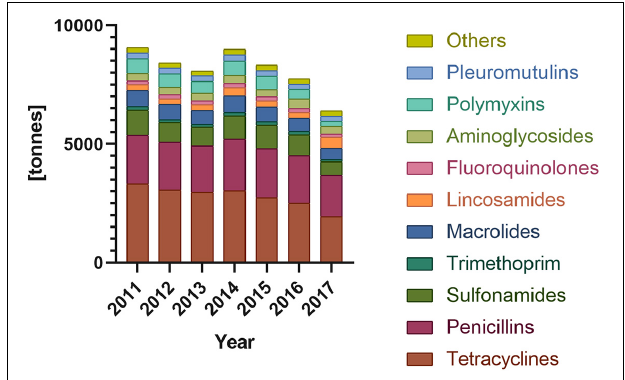
FIGURE 1 | Antibiotic sales for food-producing animals in Europe sort by antibiotic classes (according to ECDC/EFSA/EMA second joint report on the integrated analysis of the consumption of antimicrobial agents and occurrence of antimicrobial resistance in bacteria from humans and food-producing animals, 2017).